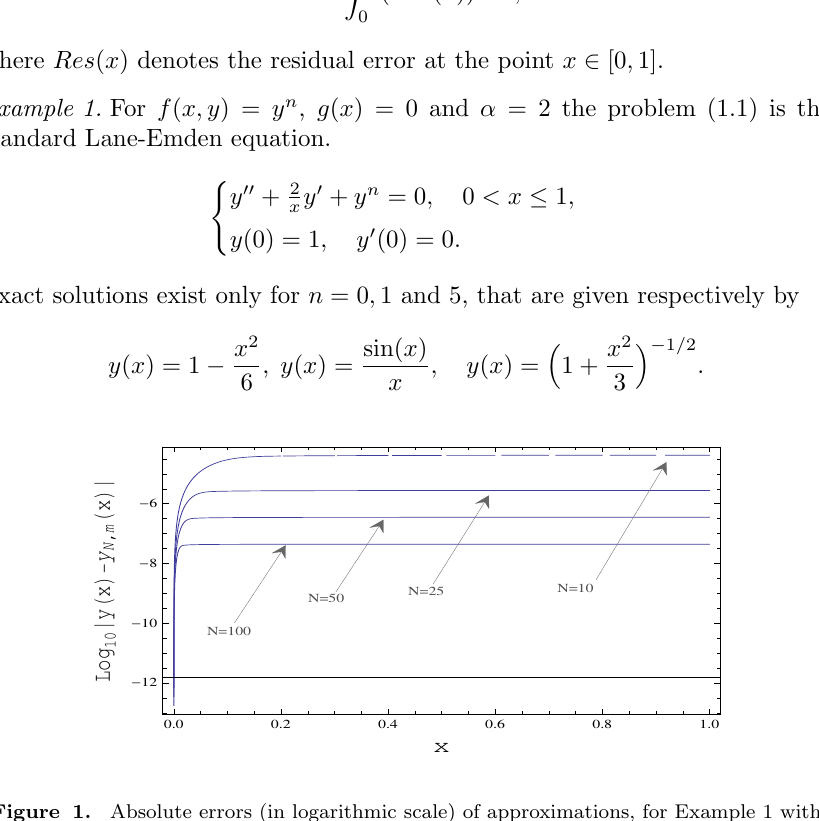
Figures 1, 2 and 3 illustrate the absolute errors (in logarithmic scale) of approxi- mations for n = 0 , 1 , 5 with m = 10 iterations and N = 10 , 25 , 50 , 100. The inte- grals of the squared residual errors are reported in Table 1 for n = 0 , 1 , 2 , 3 , 4 , 5 with m = 10 iterations and various N